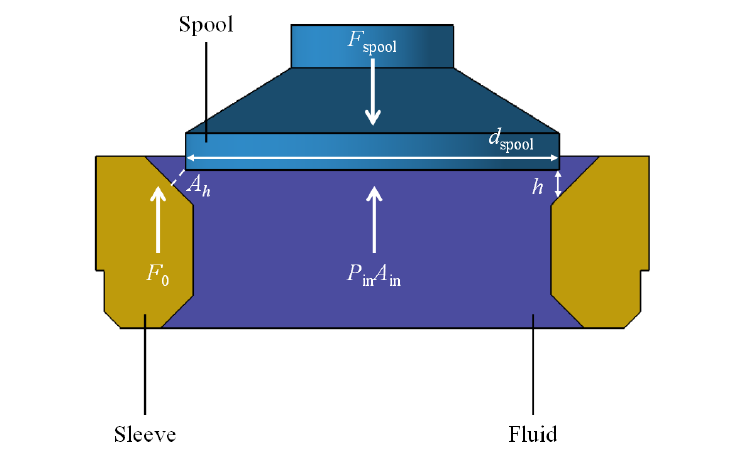
Figure 13. Cross-section diagram of the discharging